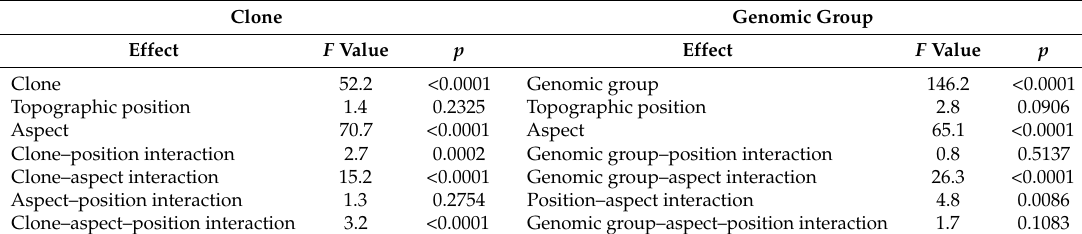
Figure 10. ( a ) Nitrogen content (N, %) and ( b ) moisture content by mass (%) of poplar wood at various tree positions for three clones (140, 187, and 188) sampled from stands located in the Piedmont (SB), the upper southern Blue Ridge Mountains (LS), and the lower southern Blue Ridge Mountains (MR). Based on the results of Proc Slice (SAS), the clone–position interaction effects were present for the three clones sampled (140, 187, and 188; p ≤ 0.0100), especially at DBH ( p = 0.0003) but not at the basal position ( p = 0.3846). The site–position interaction effects were significantly present at the three sites (LS, MR, and SB; p ≤ 0.0026) and at the basal tree position ( p ≤ 0.0100), but were marginally significant for DBH position ( p = 0.0582) and insignificant at the tree-top position ( p =